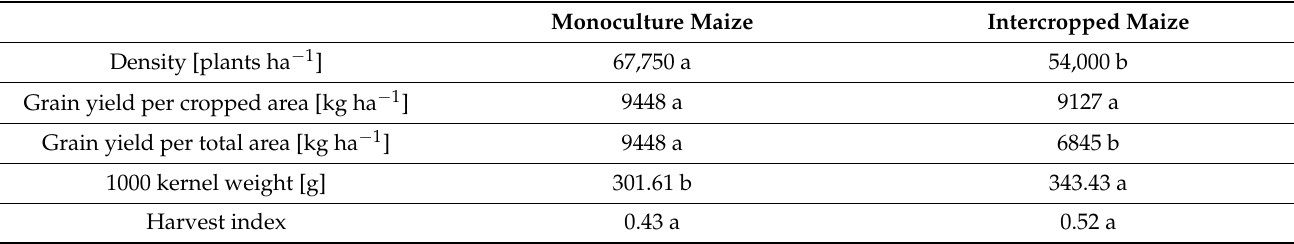
Table 4. Maize yield (dry matter basis) and yield